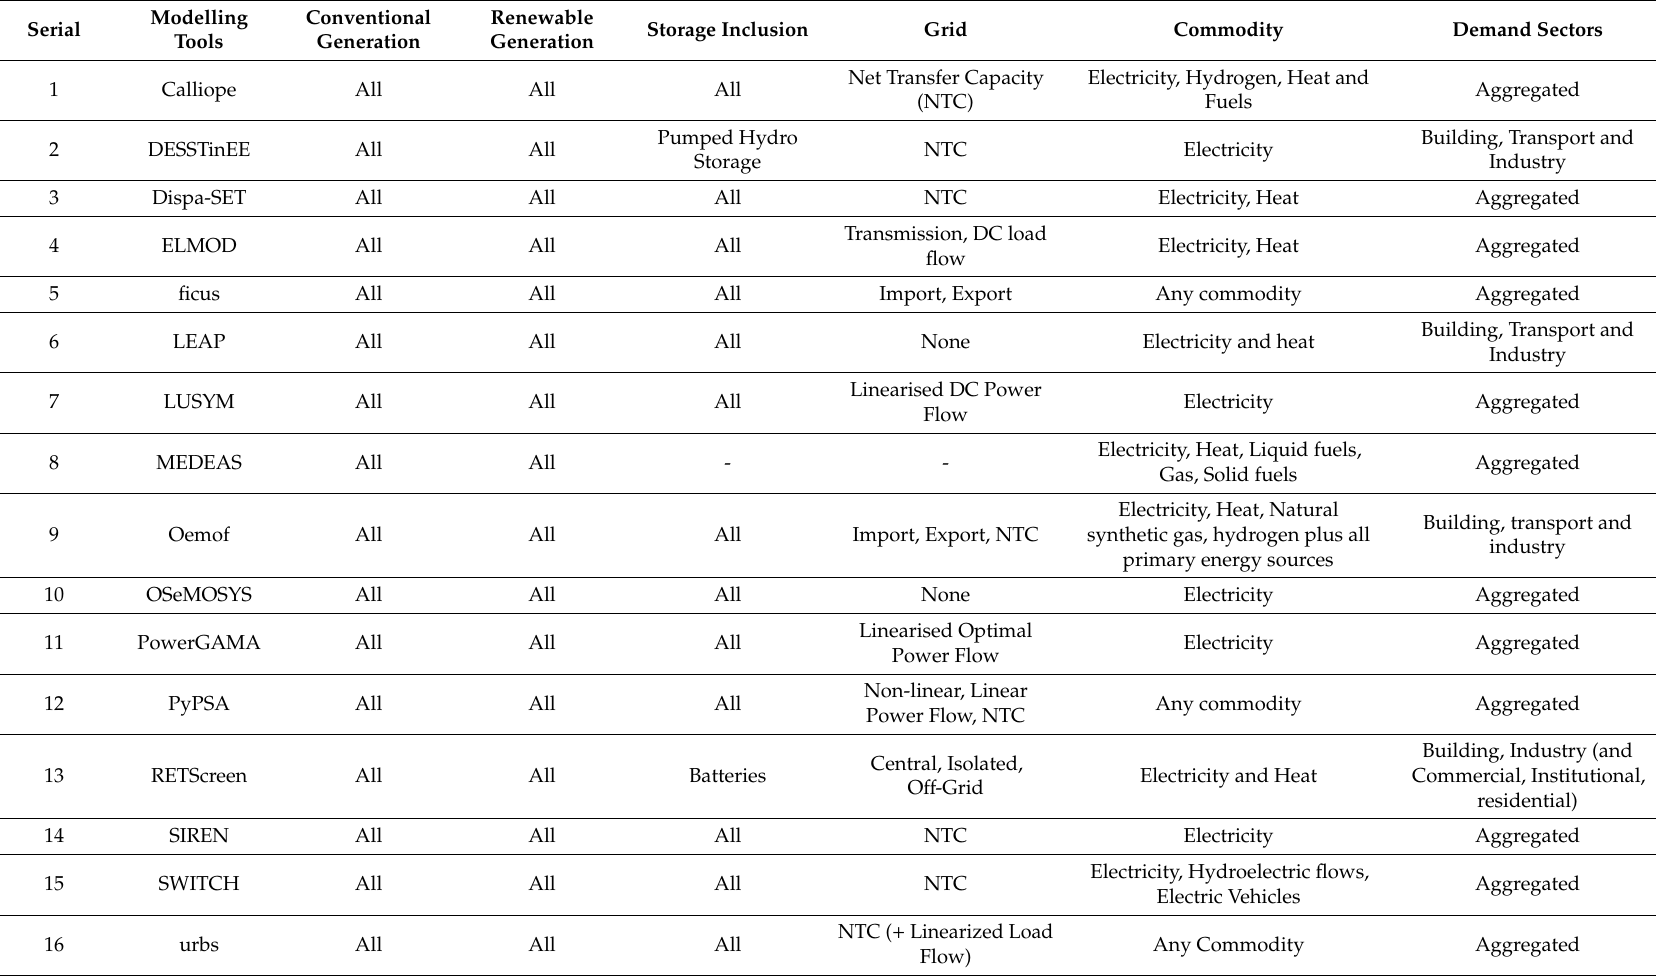
Table A3. Comparison between the 16 selected modelling tools (Part 2). Adapted from [98] and